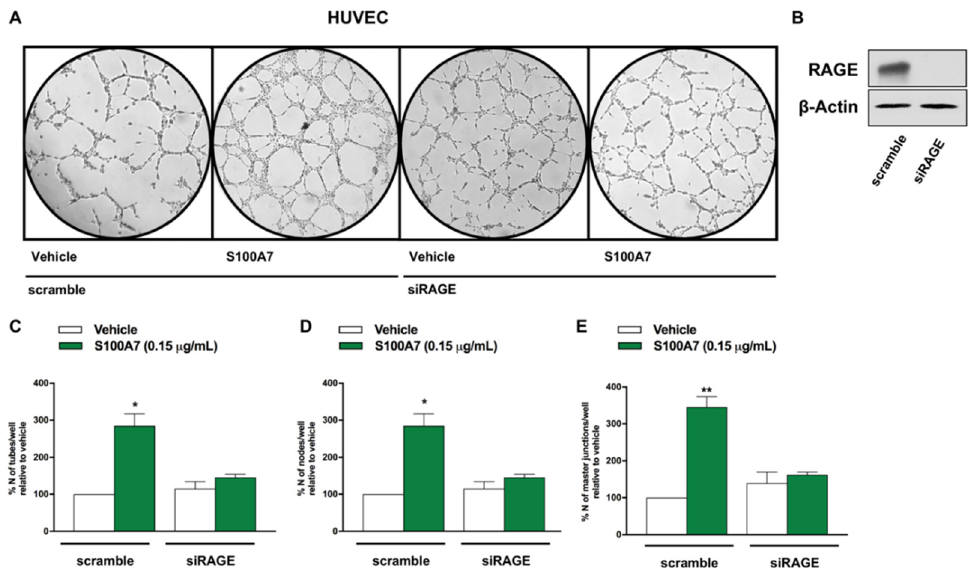
Figure 8. S100A7 triggers endothelial tube formation through the involvement of RAGE. ( A ) HUVECs were transfected with siRAGE (10 nM) or non-targeting scramble siRNA for 24 h. Thereafter, tube formation assay was performed on HUVECs, which were detached and cultured in Endothelial Basal Medium supplemented with either vehicle or S100A7 (0.15 µ g/mL). Tube formation was evaluated 8 h after HUVEC seeding. ( B ) Efficacy of RAGE silencing in HUVECs. ( C – E ) Quantification of the number of tubes, number of nodes and number of master junctions observed in HUVECs, as indicated. Data shown are the mean ± SEM of at least two independent experiments performed in duplicate. (*) p < 0.05; (**) p <